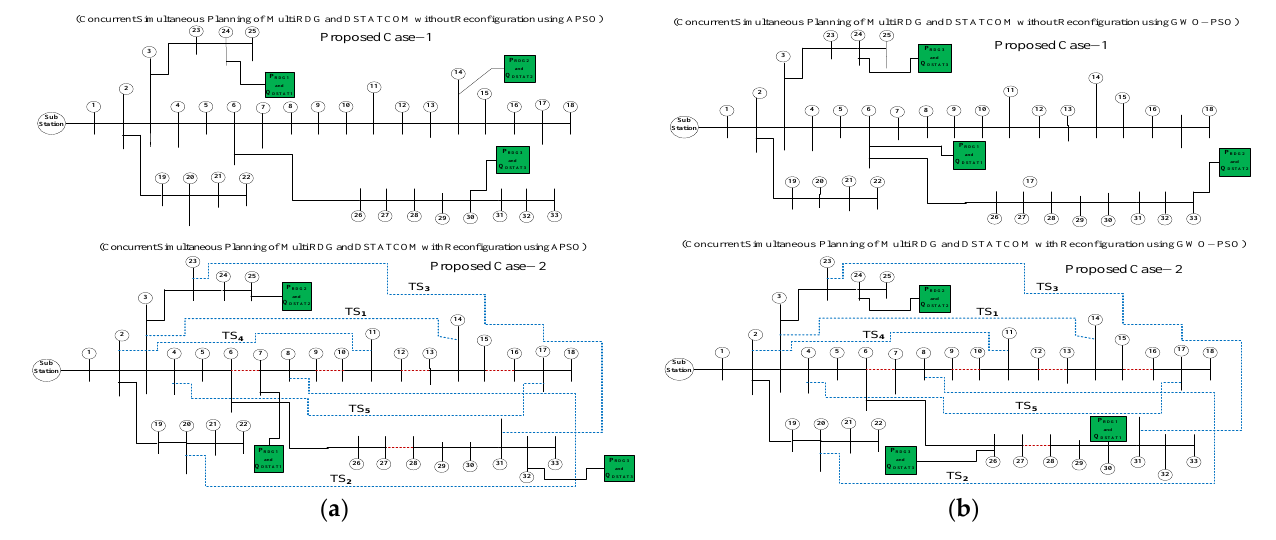
Figure 9. Proposed IEEE 33 bus RDN for both proposed cases; ( a ) APSO, ( b ) GWO-PSO.